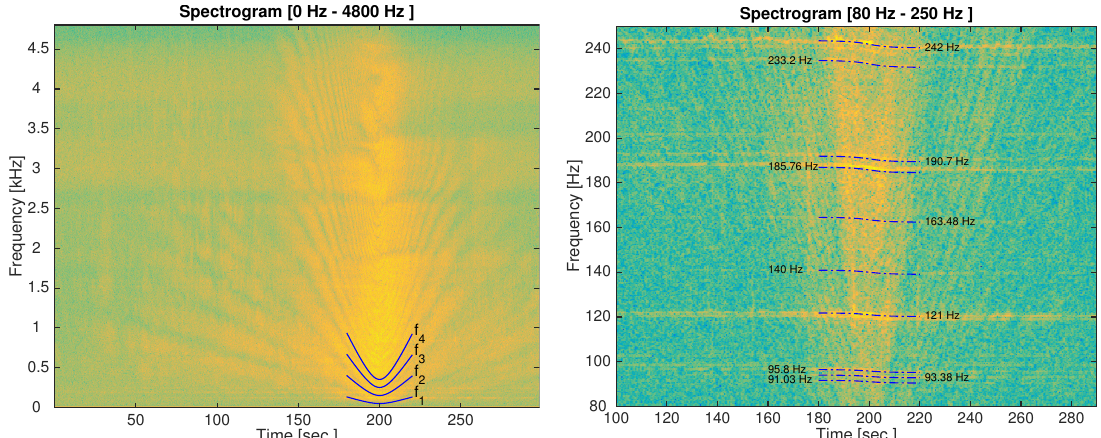
Figure 9. Spectrogram of a passing vessel in El Gorguel (Cartagena) and some of its corresponding frequency destructive-interference curves ( left ) as well as the Doppler shift curves ( right ). Spectrogram settings: FFT 1024 for the left spectrogram and FFT 16384 for the right spectrogram, Hamming window and overlap of